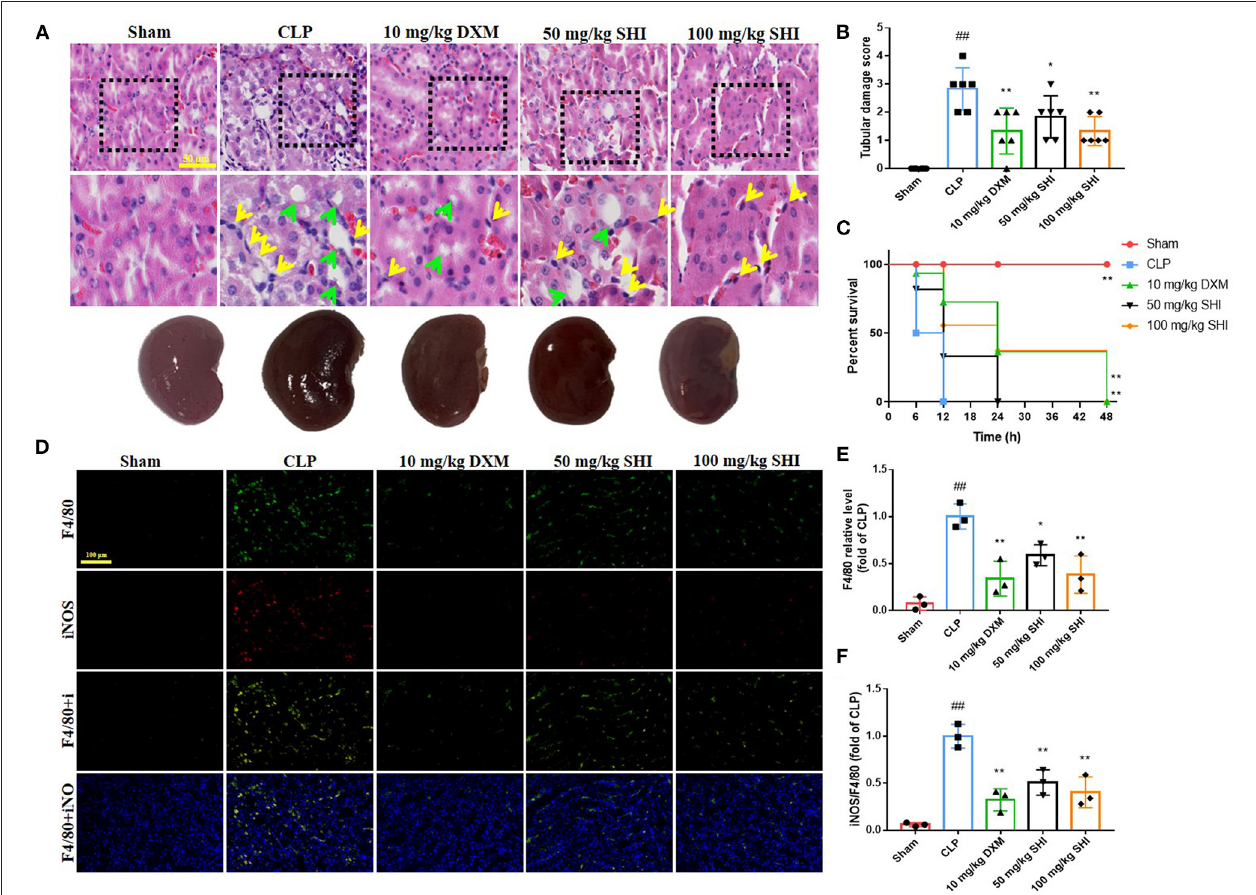
FIGURE 1 | The effects of Shionone on sepsis-induced acute kidney injury model rats. (A) Kidney was collected 24h after the stimulus for the evaluation of histopathological changes using HE staining, yellow arrow indicate inflammatory cell infiltration and green arrow indicate vacuolar degeneration ( n = 3). (B) The tubular score of each group ( n = 3). (C) The survival percentage of mice in each group ( n = 6). (D) Representative fluorescent picture of F4/80 (biomarkers of macrophages) and iNOS (biomarkers of M1 type macrophages) of kidney in sham and kidney injury groups ( n = 3). (E) Relative fluorescence of F4/80 of kidney in sham and kidney injury groups ( n = 3). (F) Relative fluorescence of iNOS of kidney in sham and kidney injury groups ( n = 3). Sham group was used as a negative control and CLP group as a positive control. Results are expressed as ± SD for independent experiments, ## p < 0.01 vs. Sham group, and * p < 0.05 vs. CLP group, ** p < 0.01 vs. CLP group, one ANOVA followed by Tukey’s post-hoc